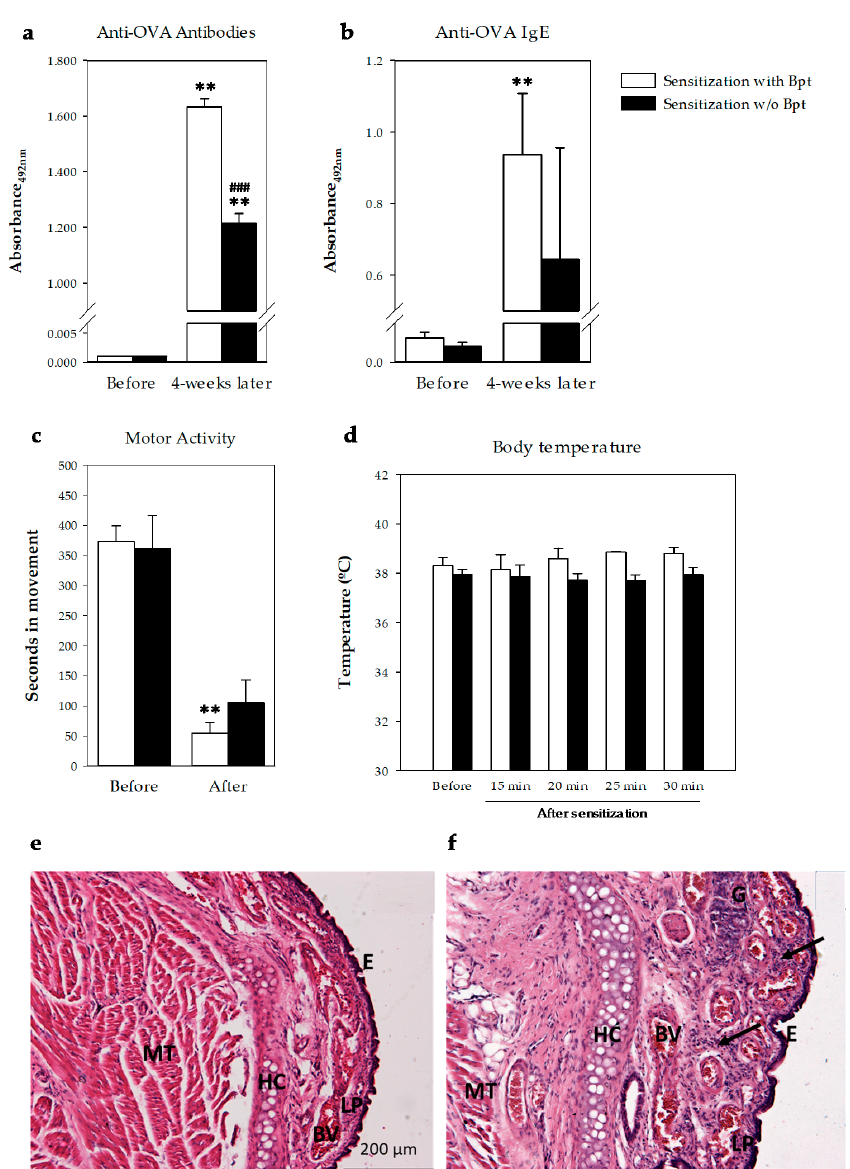
Figure 2. Effect of sensitization with (white bars) or without (w/o, black bars) Bpt on ( a ) serum total anti-OVA antibodies and ( b ) serum anti-OVA IgE before and 4 weeks after sensitization. Changes on ( c ) motor activity and ( d ) body temperature before and after the challenge with i.n. OVA (50 mg/mL) in sensitized rats with (white bars) or without (black bars) Bpt. Results are expressed as mean ± standard error (N = 4) of absorbance units. Significant differences: ** p < 0.01 vs. basal values; ### p < 0.001 vs. sensitization with Bpt. Changes in respiratory airway 24 h after the i.n. challenge ( f ) in comparison with non-challenged animals ( e ). Representative histological images of respiratory mucosa of nasal sections stained with hematoxylin and eosin, 100×, scale bar = 200 µm. E, epithelium; LP, lamina propria; BV, blood vessels; HC, hyaline cartilage; MT, muscle tissue; G, gland. Arrow indicates leukocyte infiltrate.